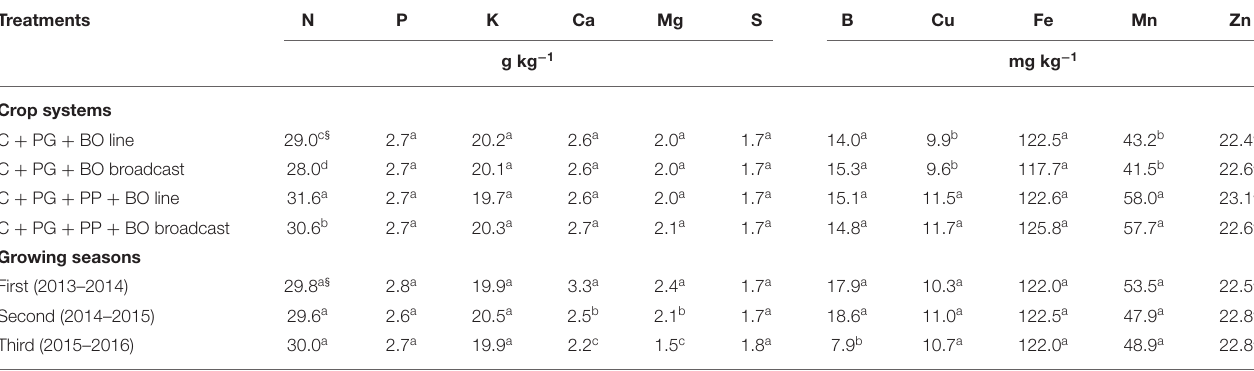
TABLE 3 | Leaf nutrient concentrations at the full flowering stage in corn to silage intercropped with palisade grass (C + PG) and with palisade grass and pigeon pea (C + PG + PP) with black oat (BO) oversown in lines and broadcast in three growing seasons. Treatments N P K Ca Mg S B Cu Fe Mn Zn g kg − 1 mg kg −